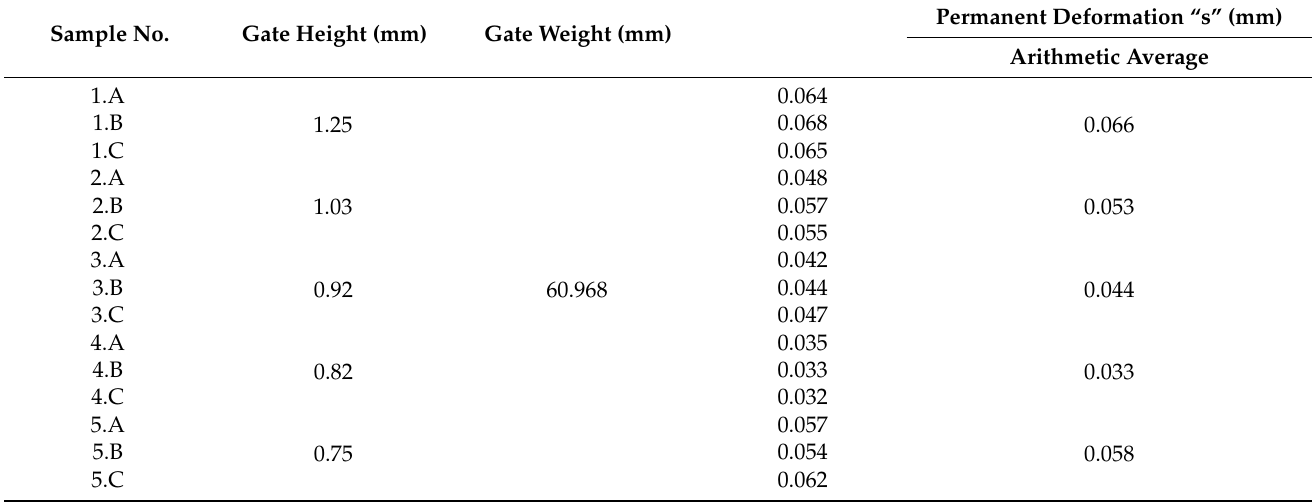
Table 8. Values of permanent deformation “s” in relation to change of the ingate height. Sample